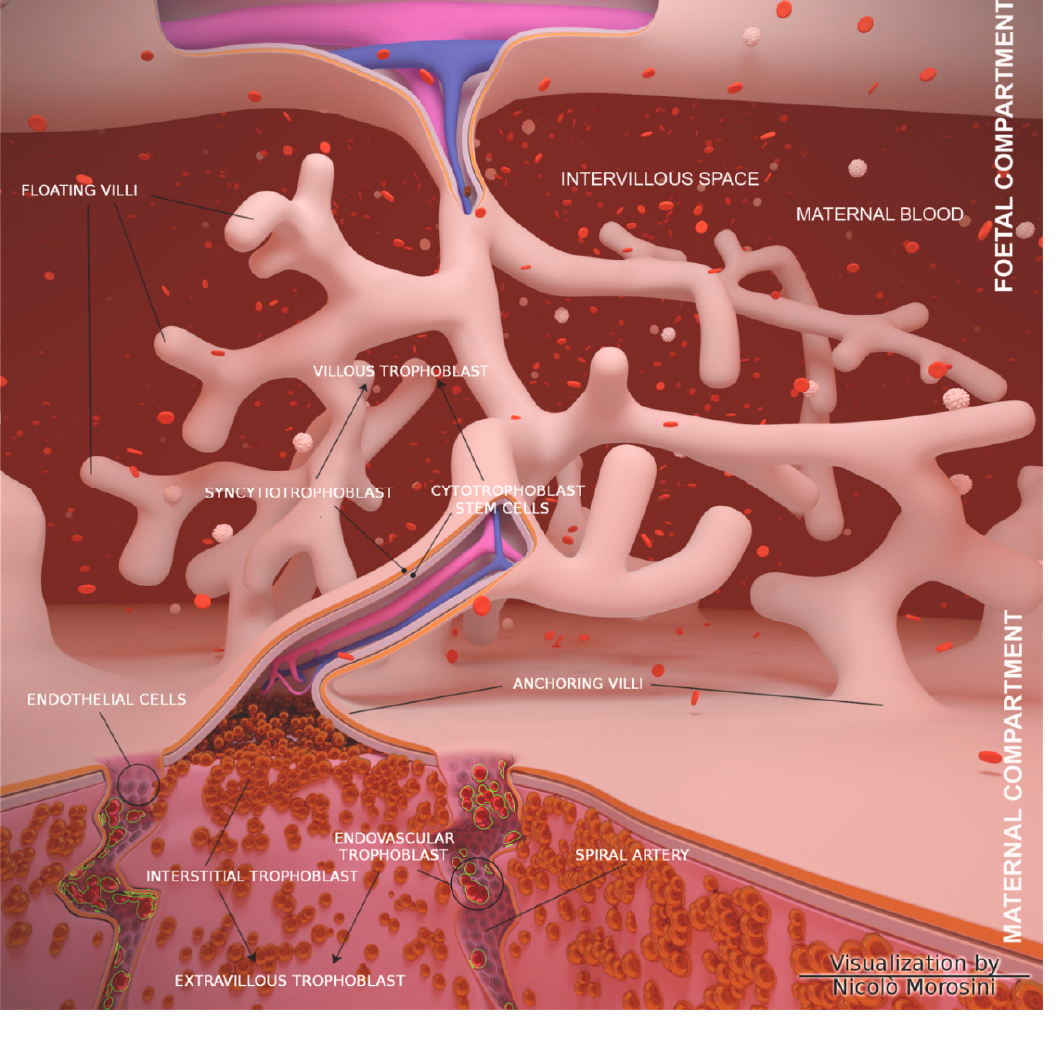
Figure 1. Schematic representation of the placenta morphology. Cartoon showing an overview of the structural organization of the placenta and fetal membranes (the image was designed using the graphic design free software Blender 3D Software, Blender Foundation, Stichting Blender Foundation, Buikslotermeerplein, Amsterdam, the Netherlands). The maternal ‐ fetal interface is a direct contact between maternal (decidua) and fetal (chorion or trophoblast) tissues. Therefore, there is a separation between the maternal basal plate and the fetal plate, where the maternal spiral arteries wet the villous trees through the chorionic plate.